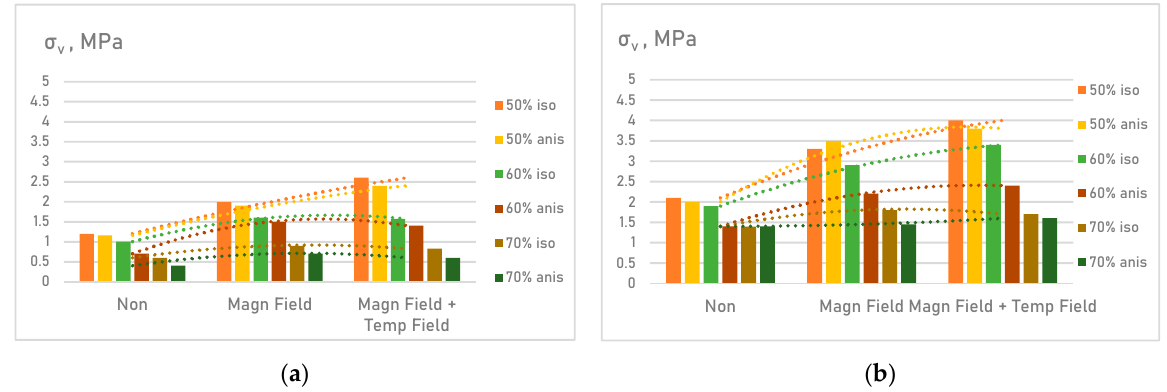
Figure 11. Research on the MAE dynamic and mechanical properties—tensile strength: ( a ) samples with P10 filling agent; ( b ) samples with atomized powdered iron filling agent.